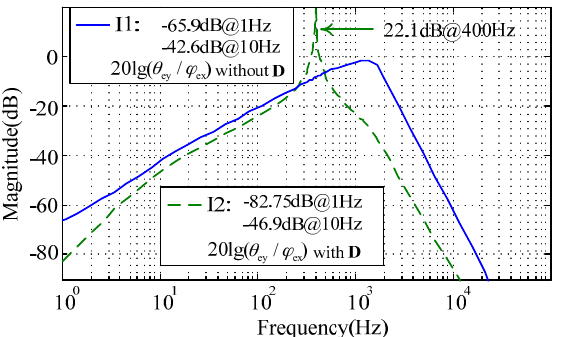
Figure 5. Block diagram of the rebalance loop in verification of the inner-loop decoupling compensation.